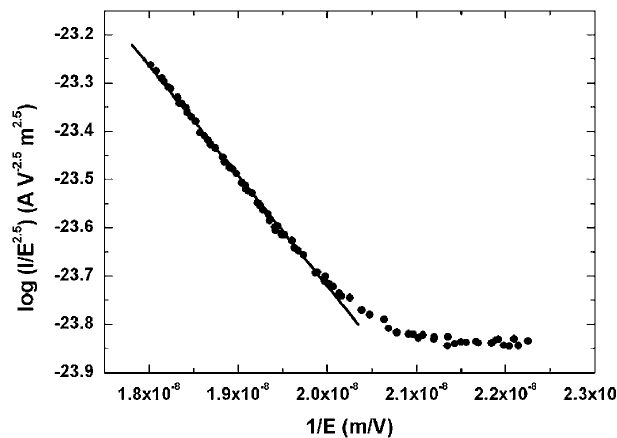
FIG. 6. Dark current measurements: in this Fowler-Nordheim plot are reported the experimental data and the linear best fit from which the (cid:8) FE and A e coefficients are